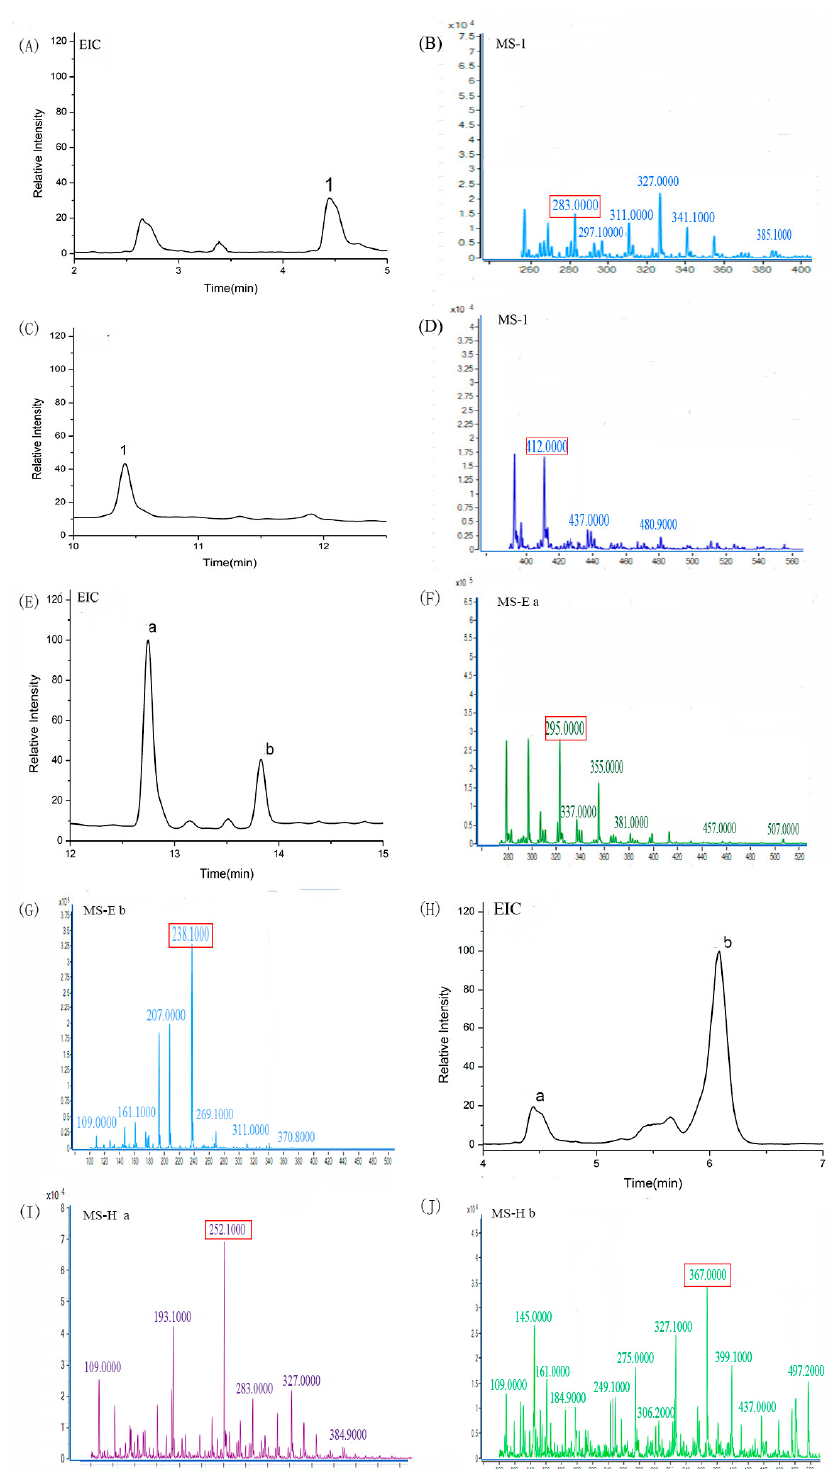
Figure 4. The extracted ion chromatography (EIC) and mass spectrometry (MS) analyses of samples for the phenolic acids reacted with glyoxal (GO). ( A ) EIC for vanillic acid reacted with GO, ( B ) MS for vanillic acid reacted with GO, ( C ) EIC for chlorogenic acid reacted with GO, ( D ) MS for chlorogenic acid reacted with GO, ( E ) EIC for ca ff eic acid reacted with GO, (F / G) MS for ca ff eic acid reacted with GO, ( H ) EIC for ferulic acid reacted with GO, ( I / J ) MS for ferulic acid reacted with